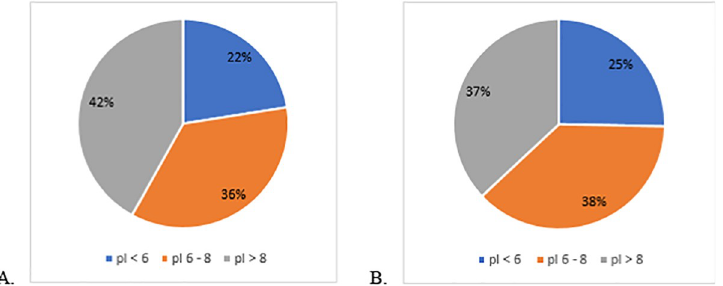
Fig 4. Distribution of proteins identified in each study group according to their isoelectric points: (A) metallic brackets, and (B) hydroxyapatite